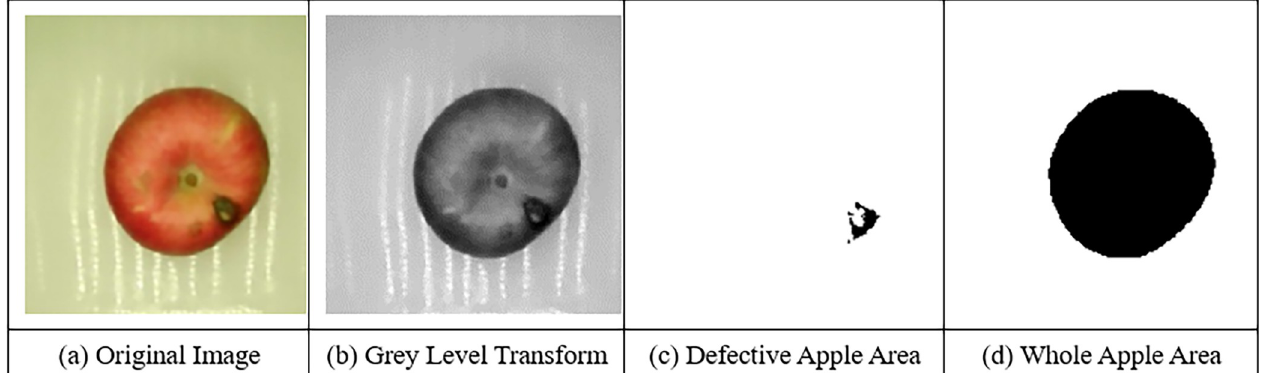
Fig 5. Process of extracting defective area of the apple. (a) Original image (b) Grey level transform (c) Defective apple area (d) Whole apple area.